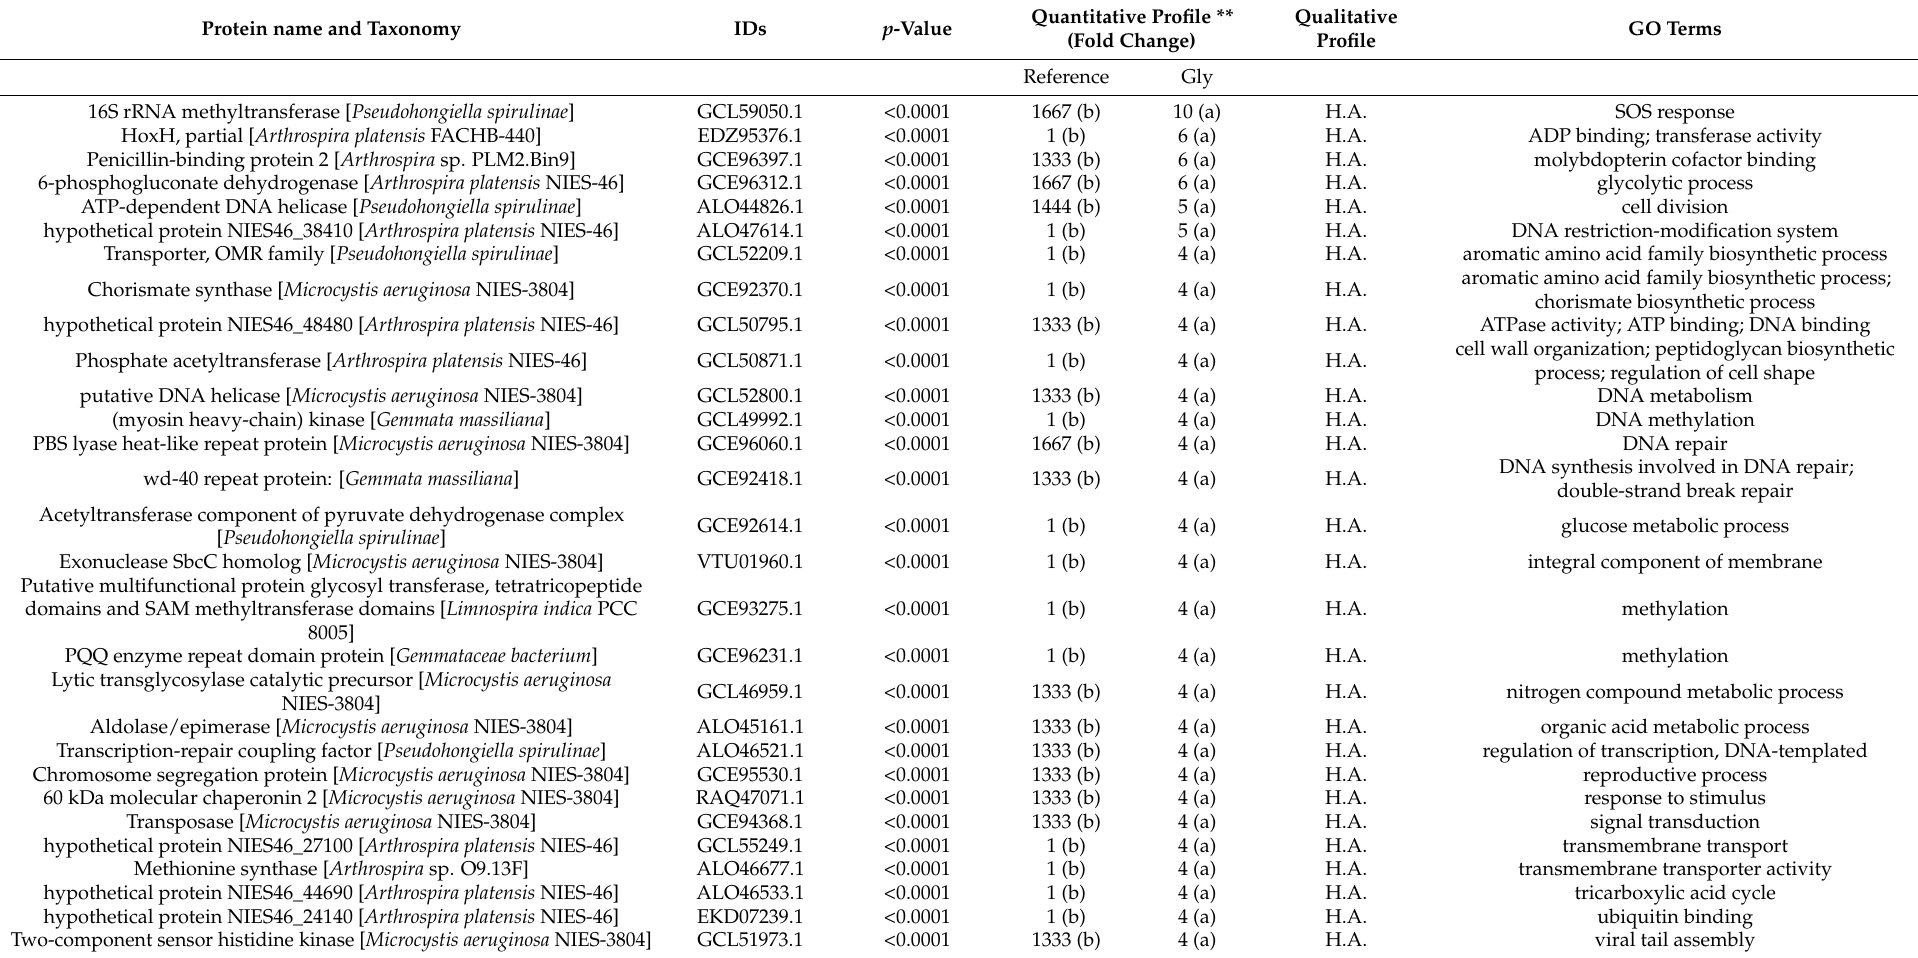
Table 1. Differentially Accumulated Proteins (DAPs) in the Glyphosate treated (Gly) A. maxima samples vs. the reference samples after 21 days of treatment. DAPs with the lowest p -values and the highest quantitative and qualitative profiles are reported *. The GO- terms, which the DAPs belong to, are also